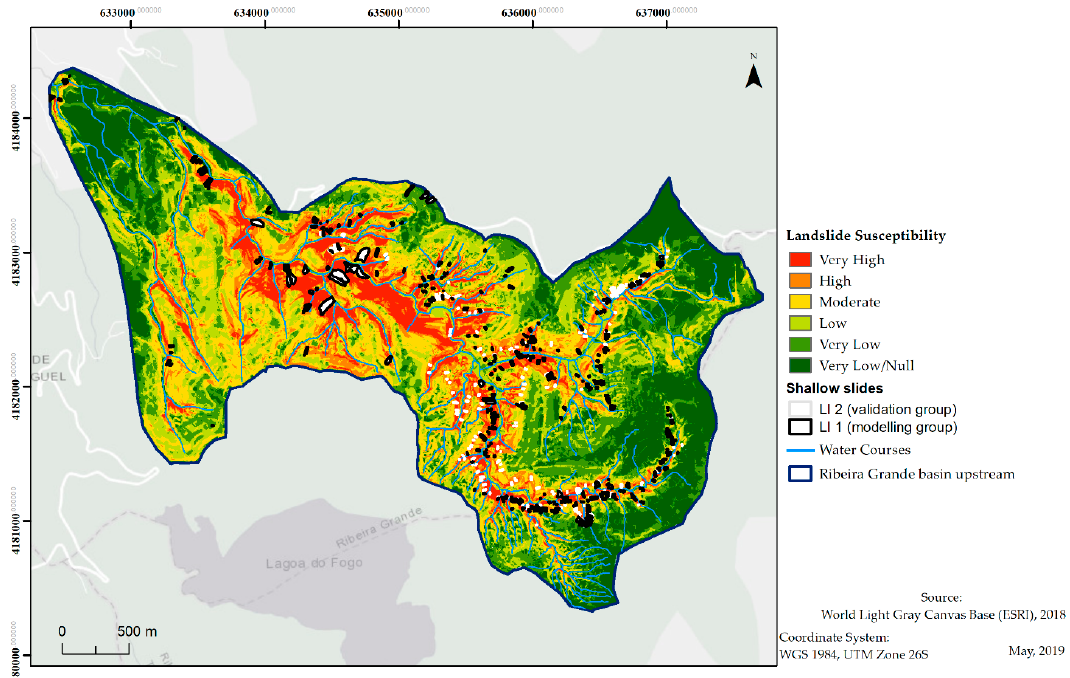
Figure 9. Model B1: Susceptibility to landslides triggered by rainfall (LI 1) in the upper part of the basin.